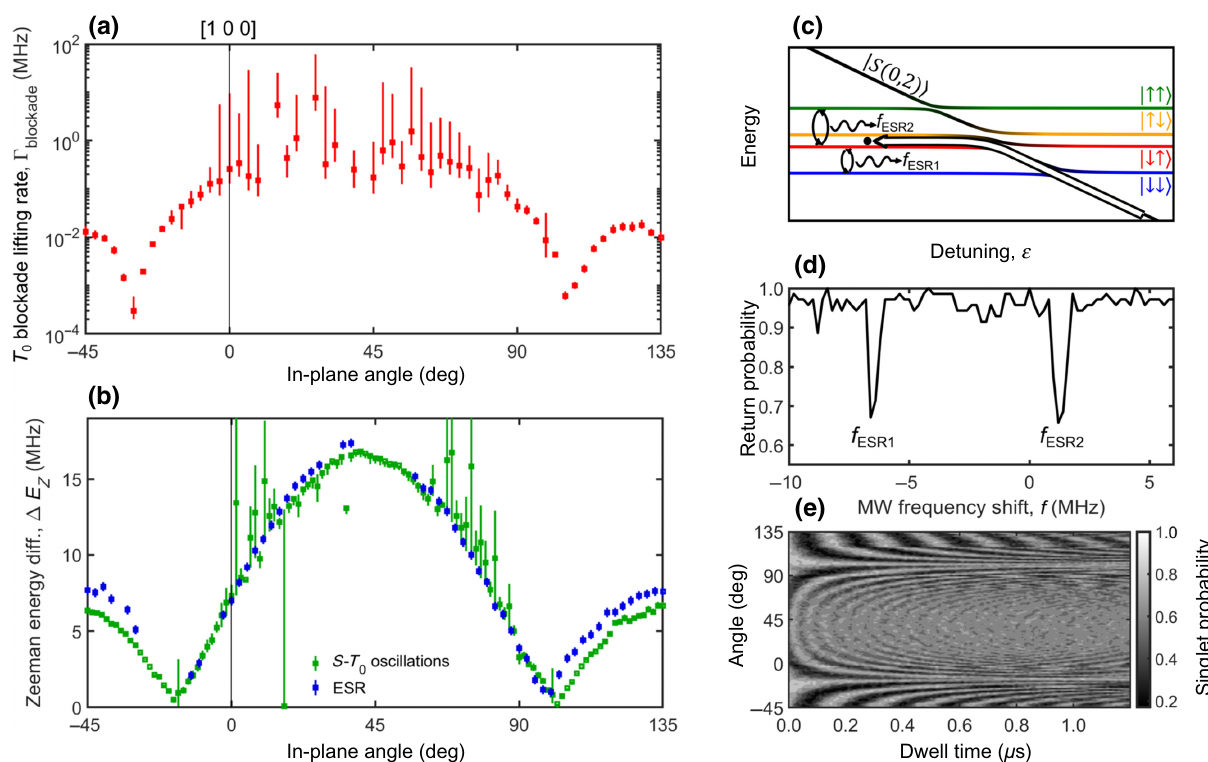
FIG. 2. Correlation between Zeeman energy difference and the rate of lifting the triplet blockade. (a) The rate of lifting the triplet blockade (red squares) extracted from decay plots similar to Fig. 1(d) and is plotted as a function of in-plane magnetic field angle for B = 600 mT. (b) The difference in Zeeman energies plotted as a function of in-plane magnetic field angle, experimentally determined with two different methods, ESR (blue squares) and S − T 0 oscillations (green squares). (c) The energy diagram of a double-dot system as a function of detuning, showing schematically the initialization and control strategy for each of the methods presented in (b) to find the Zeeman energies. The arrow shows the fast, diabatic plunge into (1,1), which initializes into | S ( 1, 1 ) (cid:2) and allows for observation of S − T 0 oscillations. The two frequencies f ESR1 and f ESR2 in (c) are shown as dips in (d), which are the individual resonance frequencies of the electron spins in each dot. (e) The S − T 0 oscillations as a function of dwell time and in-plane magnetic field